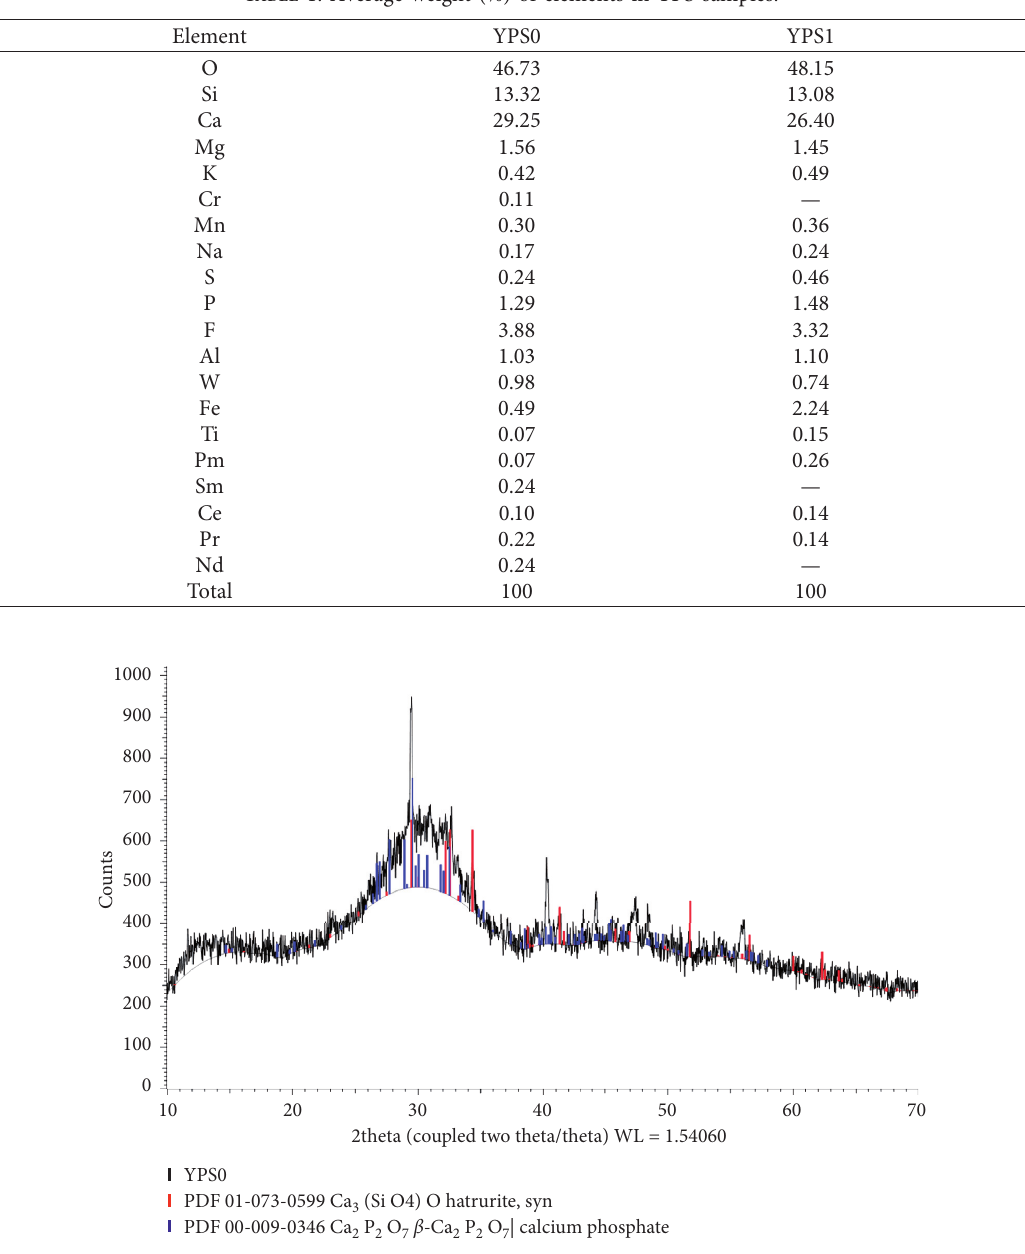
Table 1: Average weight (%) of elements in YPS